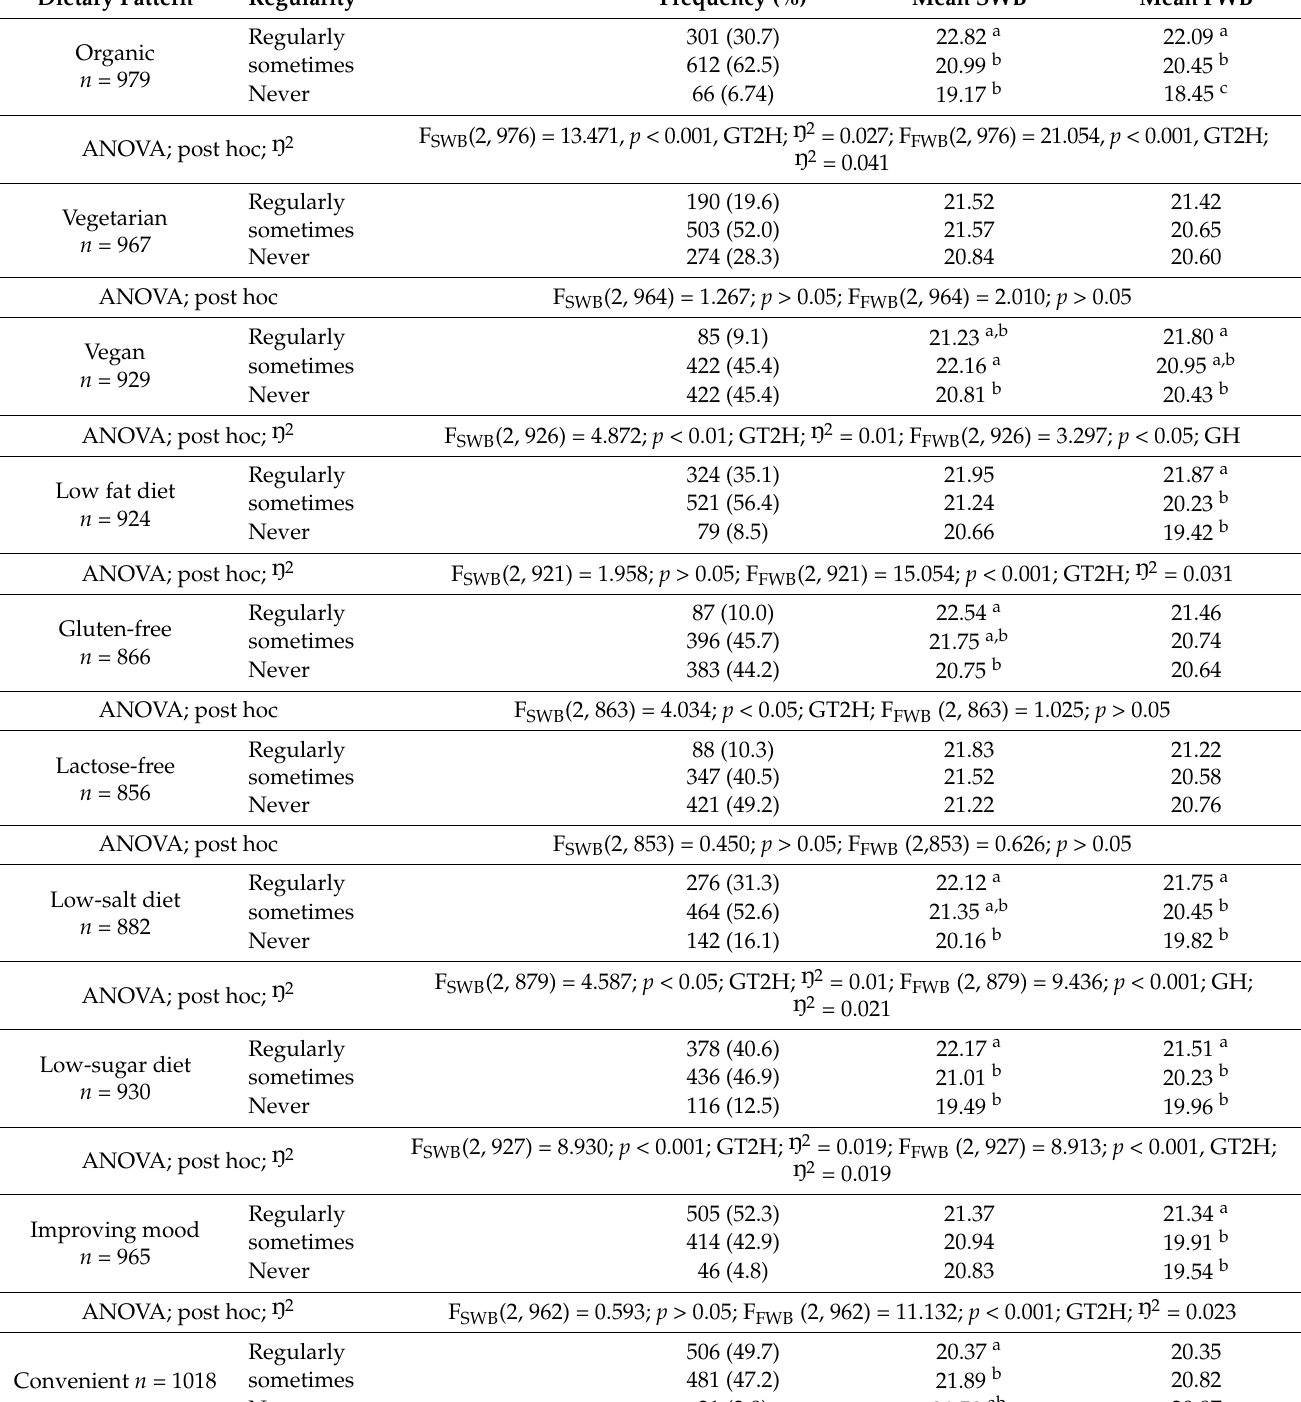
Table 3. Frequency of consumption different food category and the level of FWB and SWB.